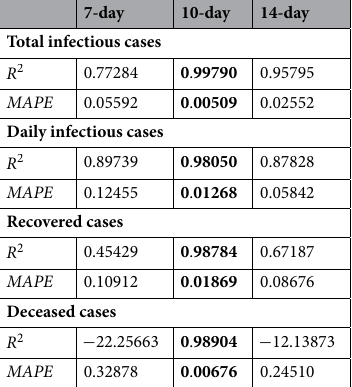
Table 1. Comparison of BeCaked performance with 7, 10 and 14 day lag. Best results are in